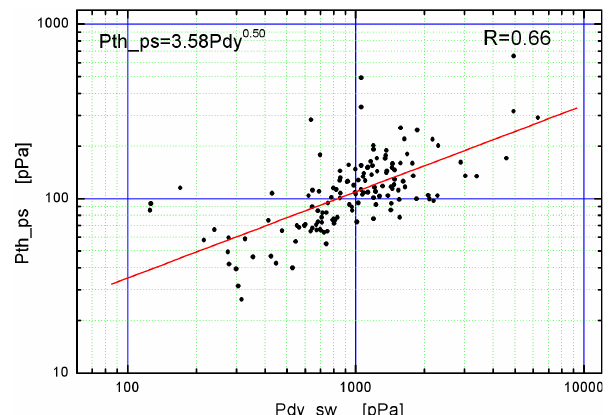
Fig. 3. The relationship between the ion thermal pressure of the solar wind and density in the plasma sheet.